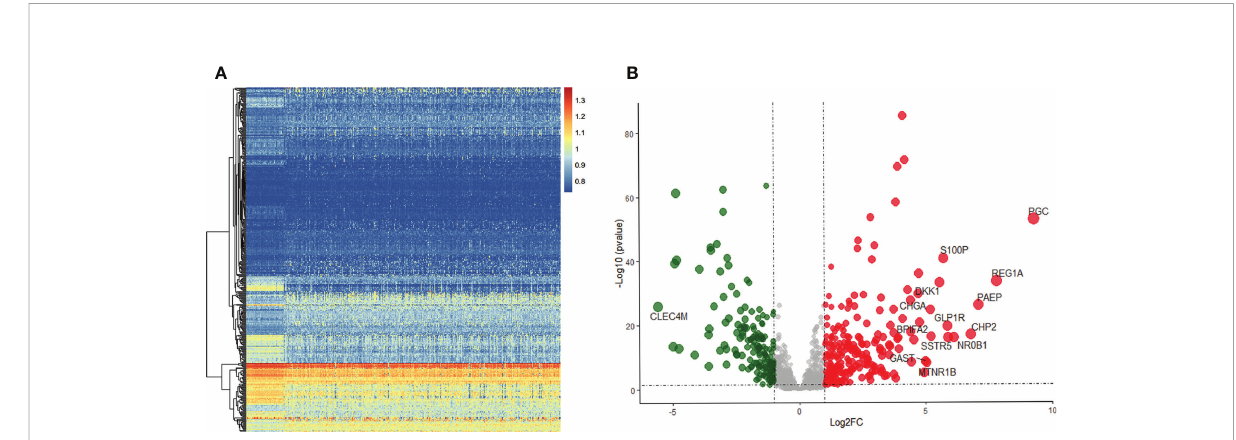
FIGURE 1 Differentially expressed IRGs in HCC. (A) Heatmap of IRGs between HCC and adjacent tissues in TCGA database. (B) The volcano plot of differential expression